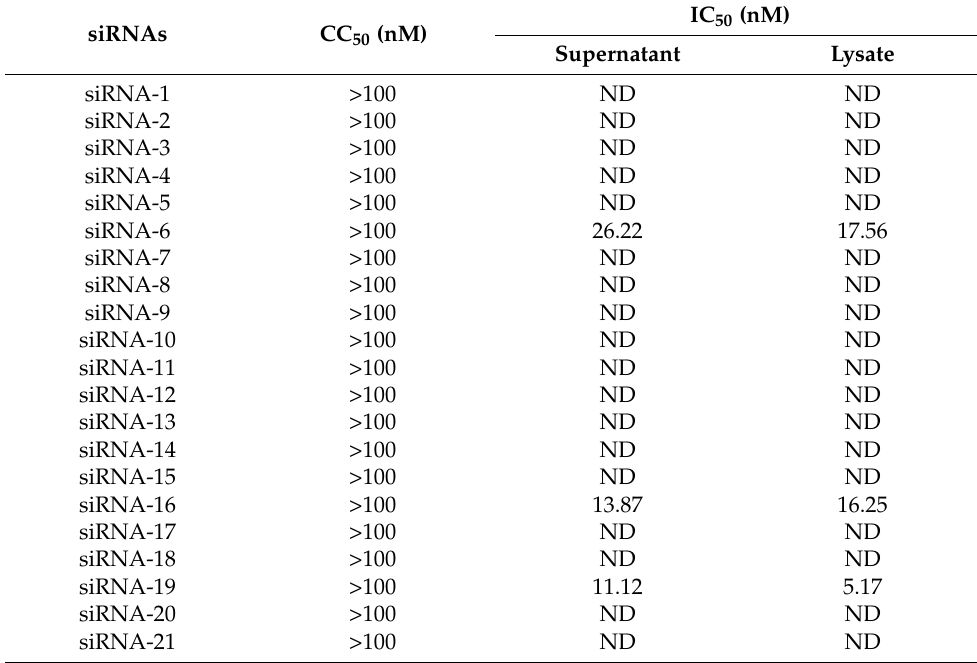
Table 2. Cytotoxicity 50% (CC 50 ) and inhibitory 50% (IC 50 ) concentrations of the different siRNAs.